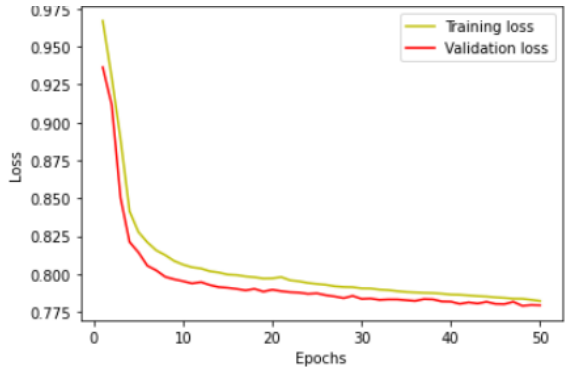
Figure 6 . Training and validation learning curves of